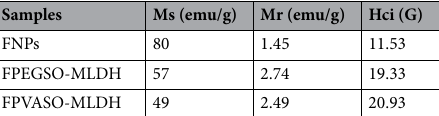
Table 1. The magnetic property of FNPs, FPEGSO-MLDH and FPVASO-MLDH.